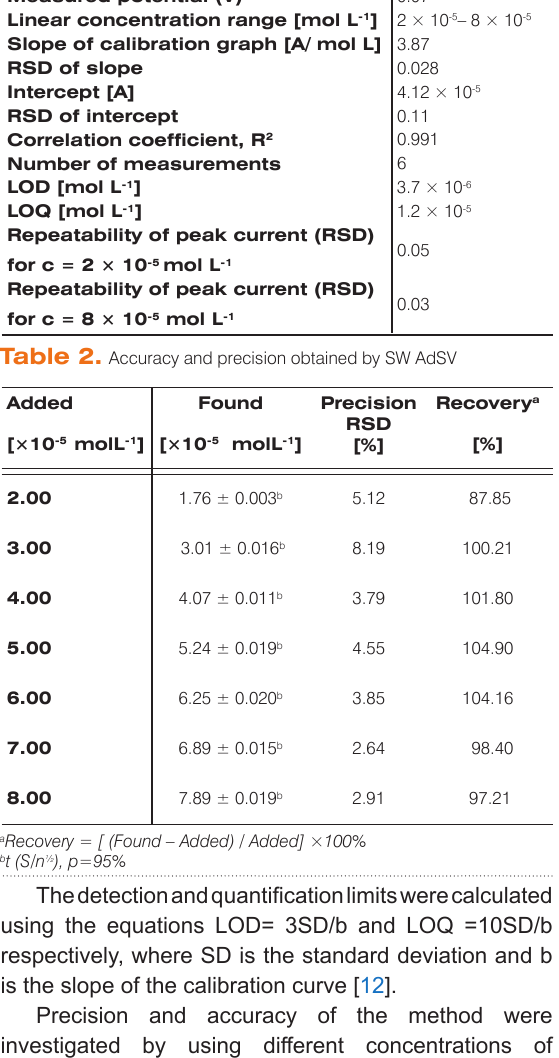
Validation parameters